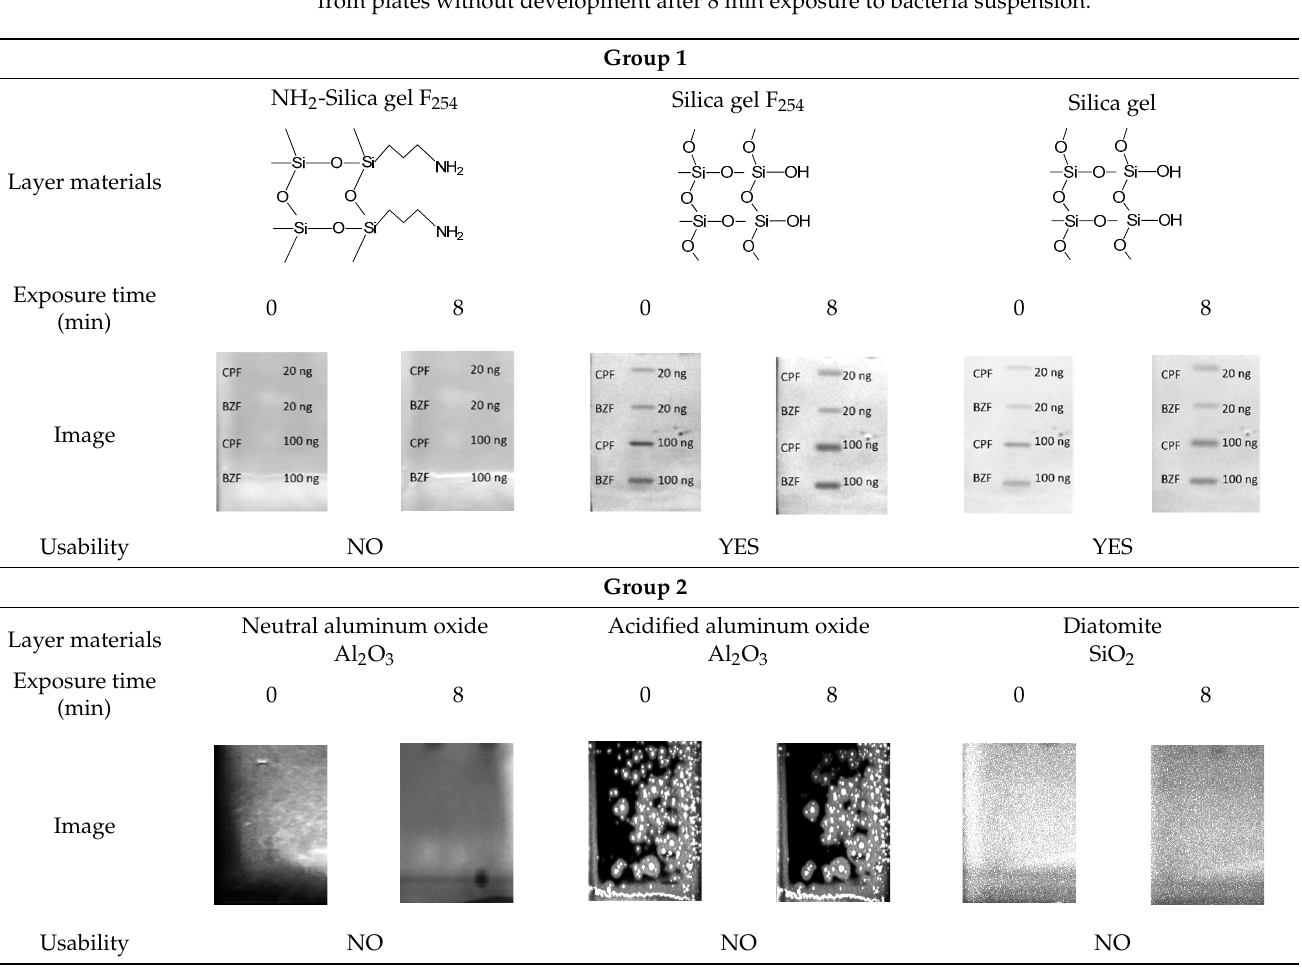
Table 1. Characterization of the e ff ects of layer materials on the detectability. Note : Images were from plates without development after 8 min exposure to bacteria suspension.